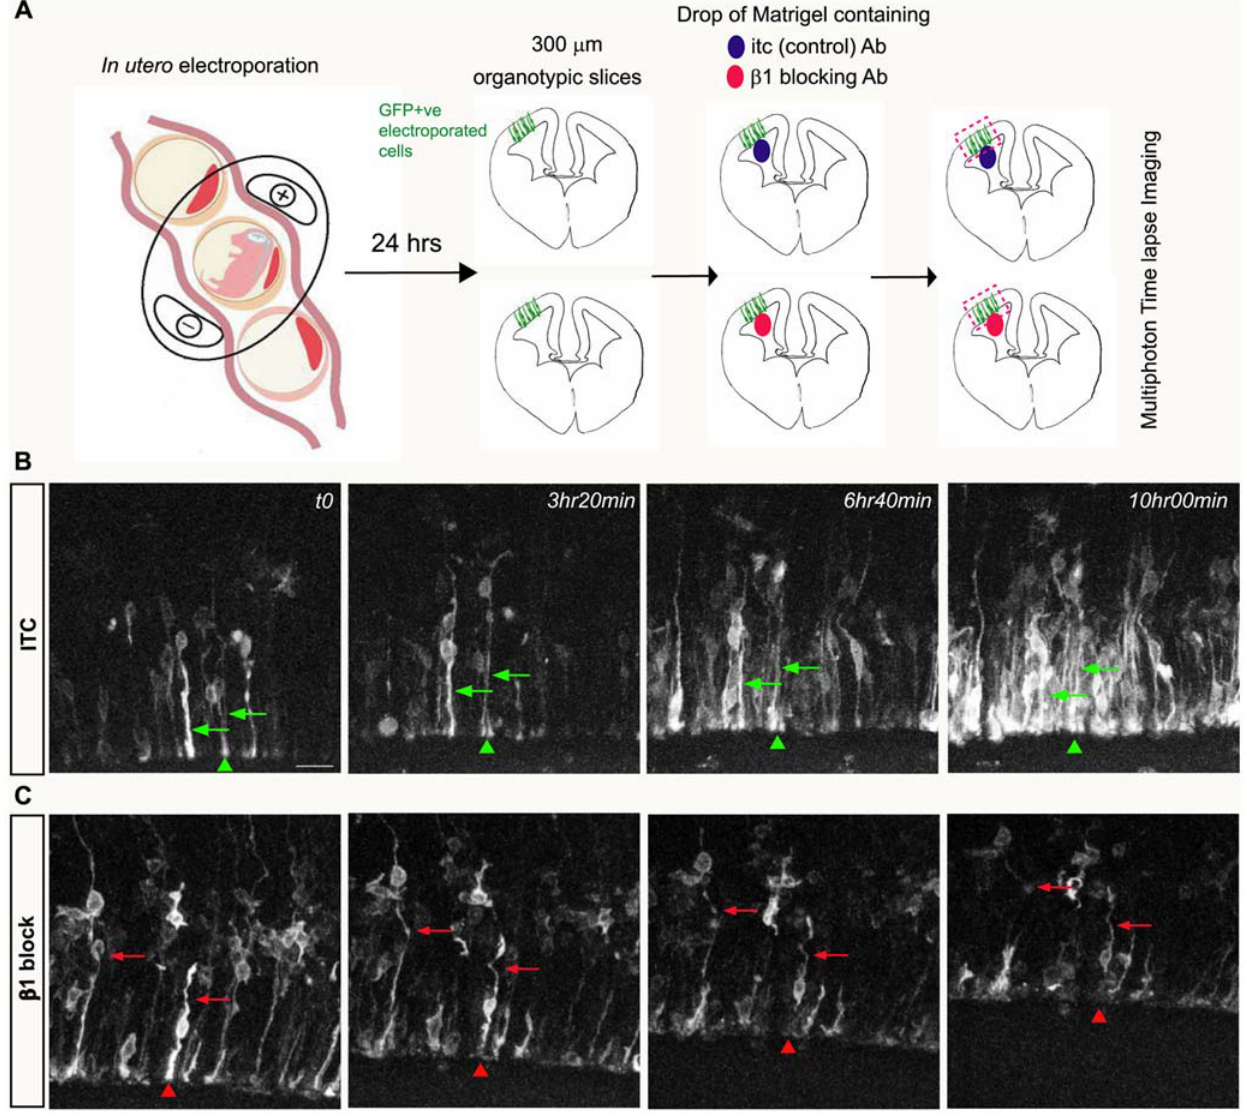
Figure 5. Time lapse analysis of NSC morphology and detachment after b 1 integrin signalling blockade at the VZ surface. (A) Experimental paradigm of the multiphoton time lapse experiments. Organotypic brain slices were prepared 24 h after in utero electroporation with eGFP-F DNA into a wild-type E14.5 embryo. A drop of growth factor–reduced matrigel containing either ITC control or b 1 blocking antibody was placed into the lateral ventricle. Automated multipoint scanning using a multiphoton laser (850 nm) was used to simultaneously monitor the behavior of two electroporated slices containing the drop of matrigel with either b 1 blocking or the ITC control antibody. (B, C) Time lapse images of 10h recording of VZ neuroepithelial integrity in the presence of ITC control (B) or b 1 blocking (C) antibody. (B) Slices in the presence of ITC antibody retain bipolar eGFP-F + cells with straight processes (green arrows) and end-feet attached to the ventricular surface (green arrowheads) throughout the 10 h of recording. (C) In presence of b 1 blocking antibody, the radial morphology of the eGFP-F cells is progressively disrupted; both basal and apical processes appear convoluted (red arrows) and the end-feet are detached from the ventricular surface (red arrowheads). Scale bar represents 25 m